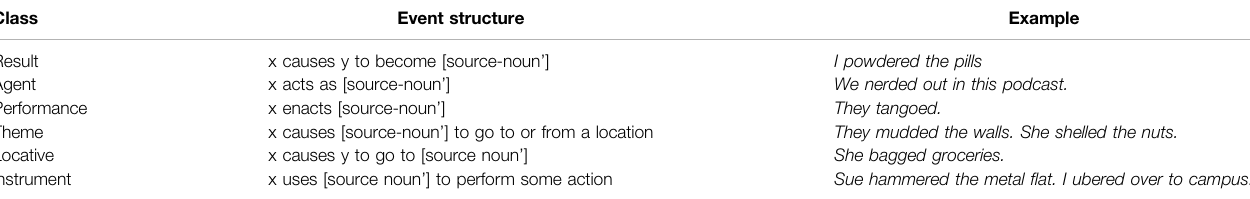
TABLE 1 | Categories of English denominal verbs (based on Gottfurcht 2008: